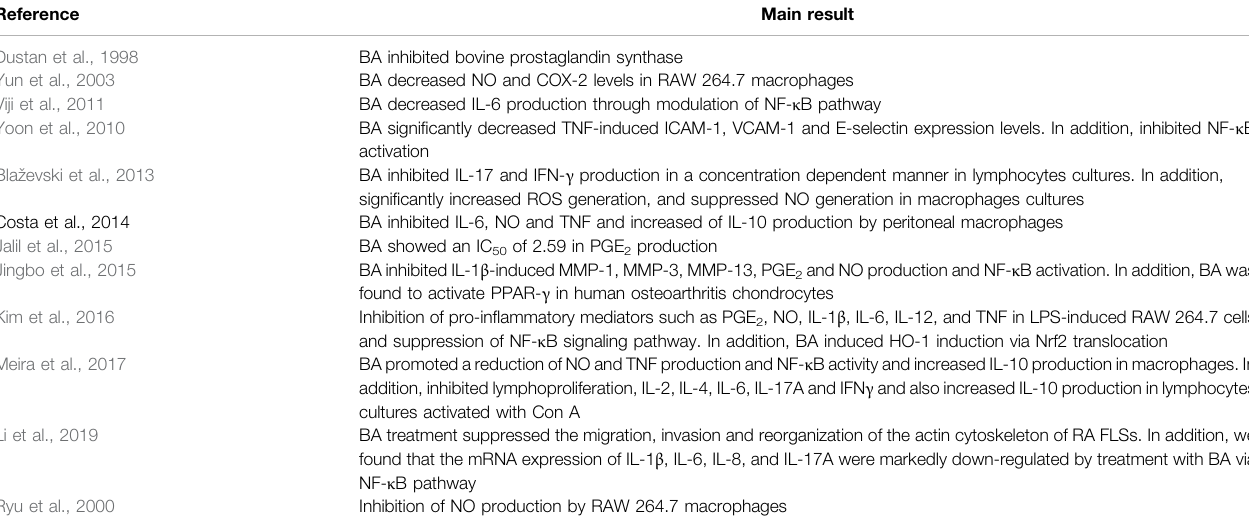
TABLE 1 | In vitro anti-in fl ammatory activity of betulinic